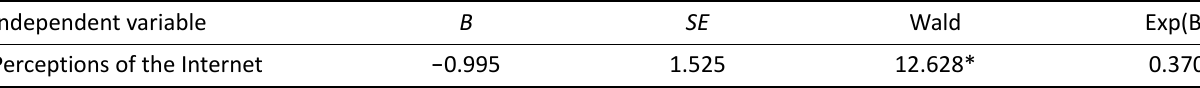
Table 4. Logistic regression results for predicting the motivation to join the course to learn how to use computer programs. Independent variable